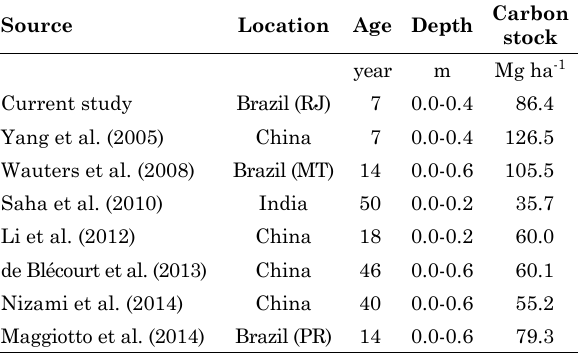
Table 5. Soil carbon stocks in different areas planted to rubber trees, compared to the average C stock seen in this